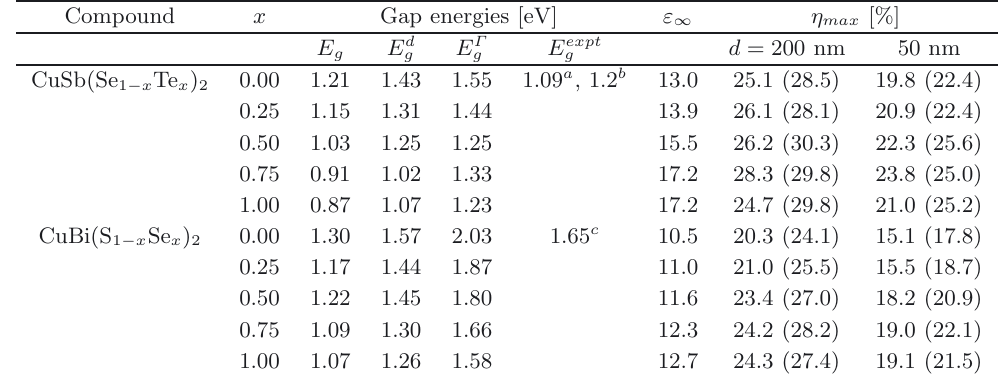
Table 1. The fundamental ( E g ), direct ( E d g ), and Γ-point ( E Γ g ) gap energies, as well as the high-frequency dielectric constant ( ε ∞ ); we present the average dielectric constant since the anisotropy is rather small. The maximum solar conversion efficiency ( η max ) is presented for two film thicknesses ( d ), and it includes both radiative and Auger recombinations (values in parenthesis are results when the Auger effect is neglected). Compound x Gap energies [eV] ε ∞ η max [%] E E d E Γ E expt d = 200 nm 50 nm g g g g CuSb(Se 1 − x Te x )